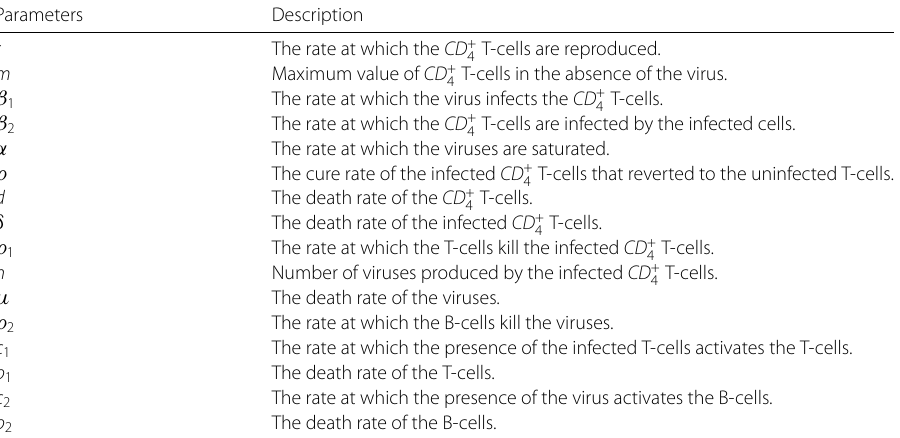
Table 1 Used parameters in HIV mathematical model Parameters